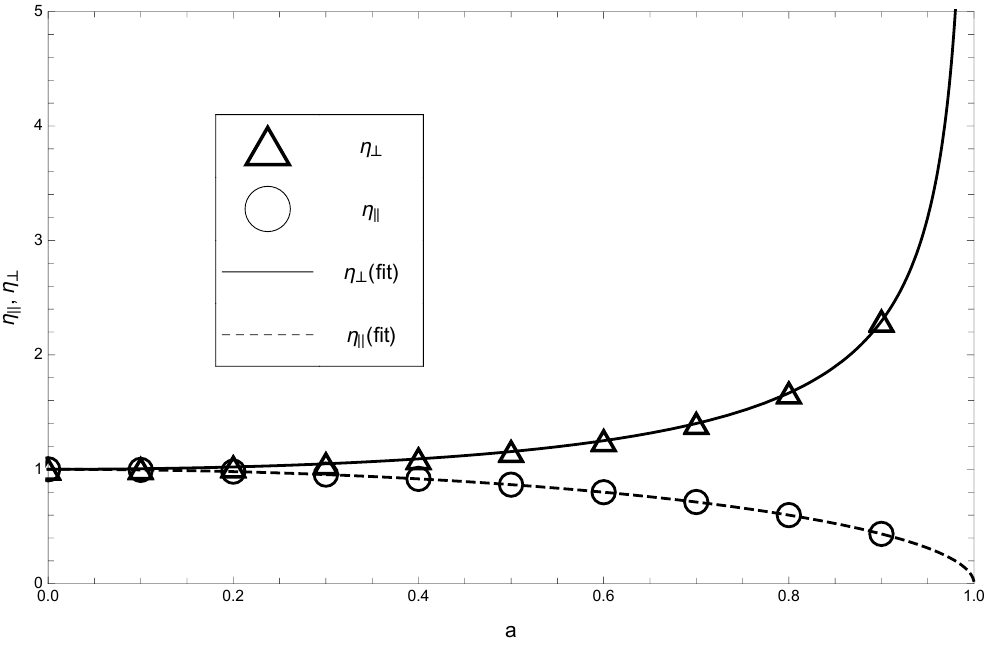
Figure 12 . Longitudinal and transverse shear viscosities of the simply spinning black hole. (cid:17) ? and (cid:17) extracted from numerics are shown as a function of the normalized angular momentum, a , jj of the (cid:13)uid/black hole. The shear viscosities of the spinning planar limit black brane are coindicent with those shown (shown analytically for (cid:17) ? , numerically shown for (cid:17) \+1" in the blackening factor in eq. (2.5). An attempt to solve this equation